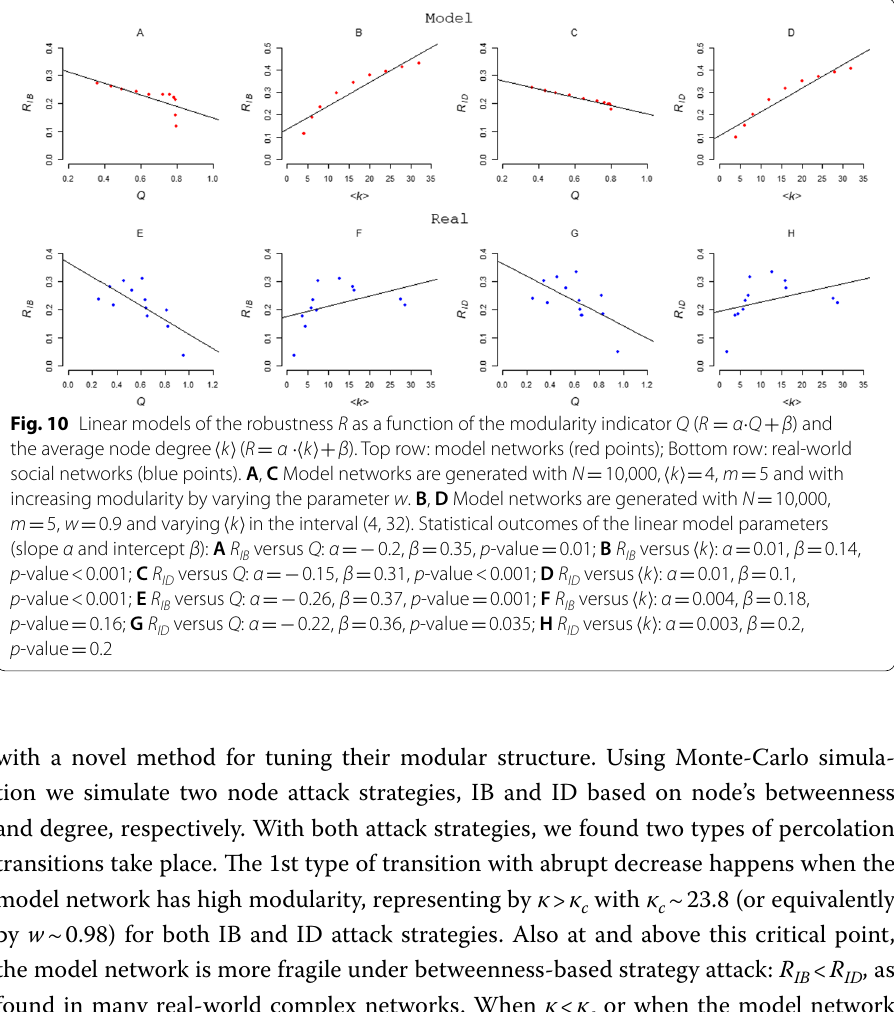
(cid:31) k (cid:30) α β ). Top row: model networks (red points); Bottom row: real‑world = · +